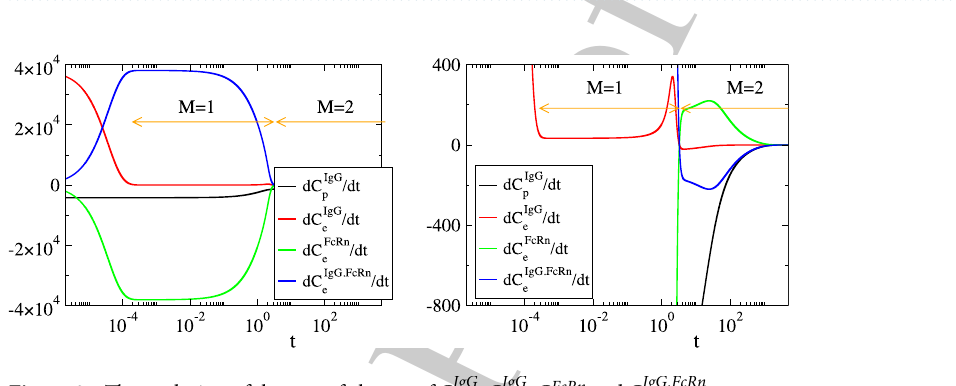
Figure 3. The evolution of the rate of change of C